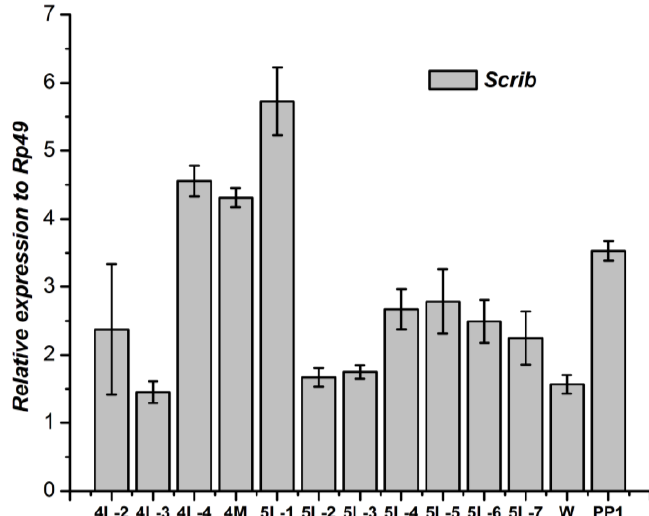
Figure 3. Developmental changes of Scrib mRNA in fat body of Bombyx mori. 4L-2 to 4L-4, the 2nd to 4th day of 4th instar larvae; 4M, the molting stage of 4th instar larvae; 5L-1 to 5L-7, the 1st day to 7th day of 5th instar larvae; W, wandering stage; PP1, the 1st day of pre-pupal